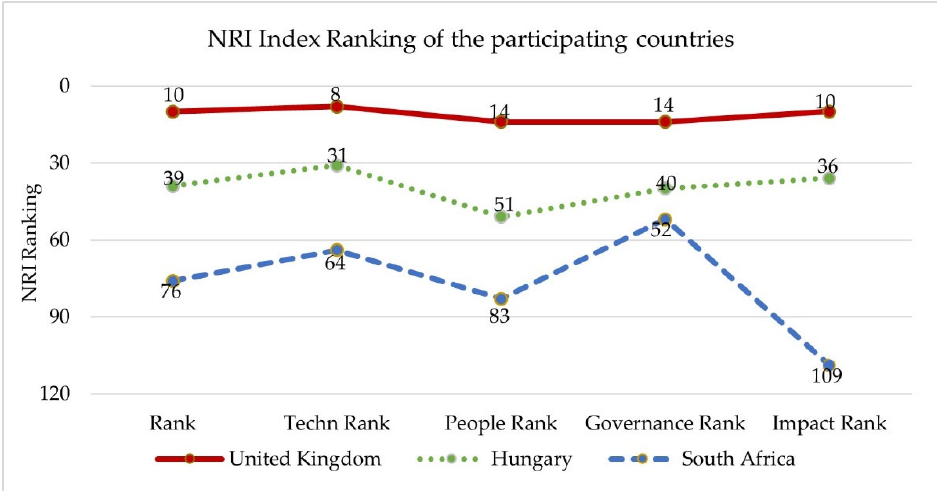
Figure 5. Network Readiness Index rankings of Hungary, South Africa, and the United Kingdom by dimension [12].